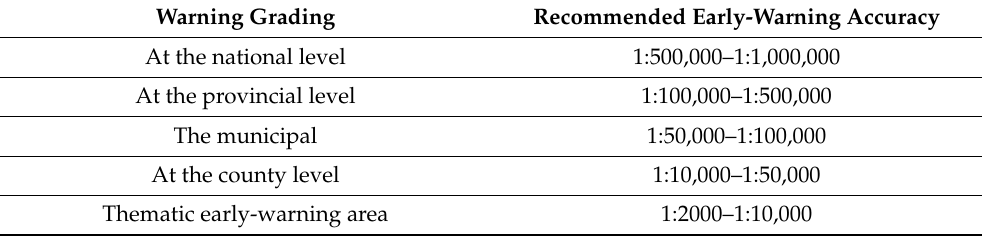
Table 3. Precision division of early-warning space (reproduced from [34]).